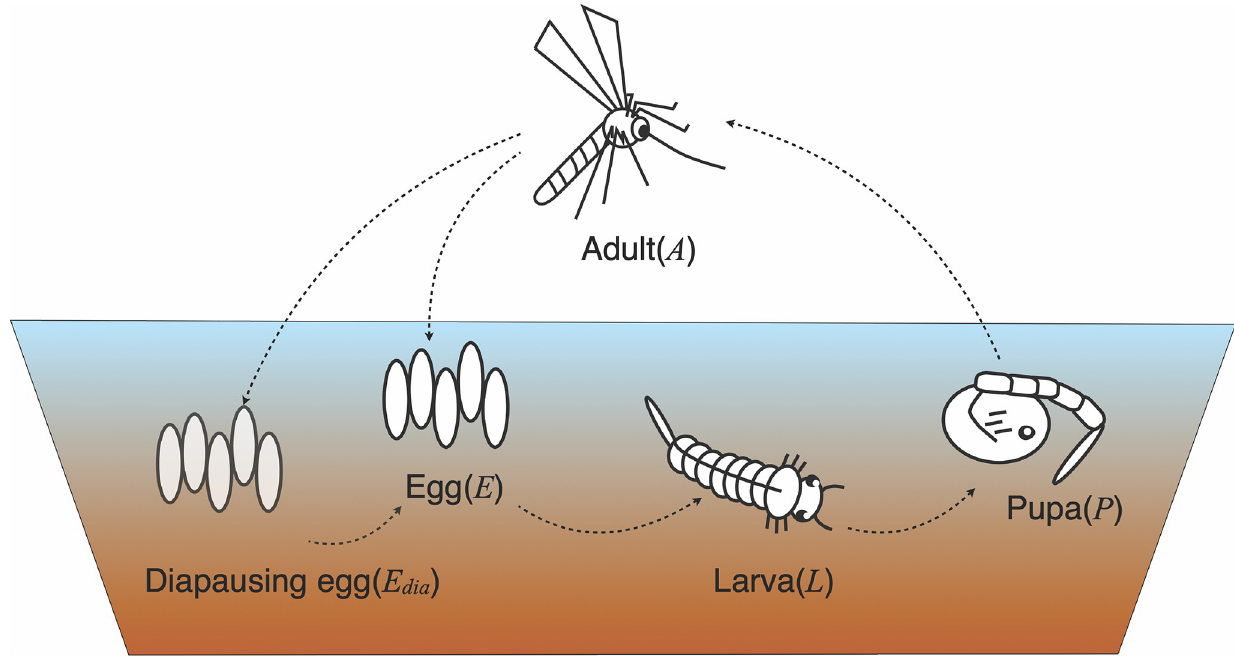
Fig 1. Framework of physiology-based climate-driven mosquito population (PCMP) model for Aedes albopictus .